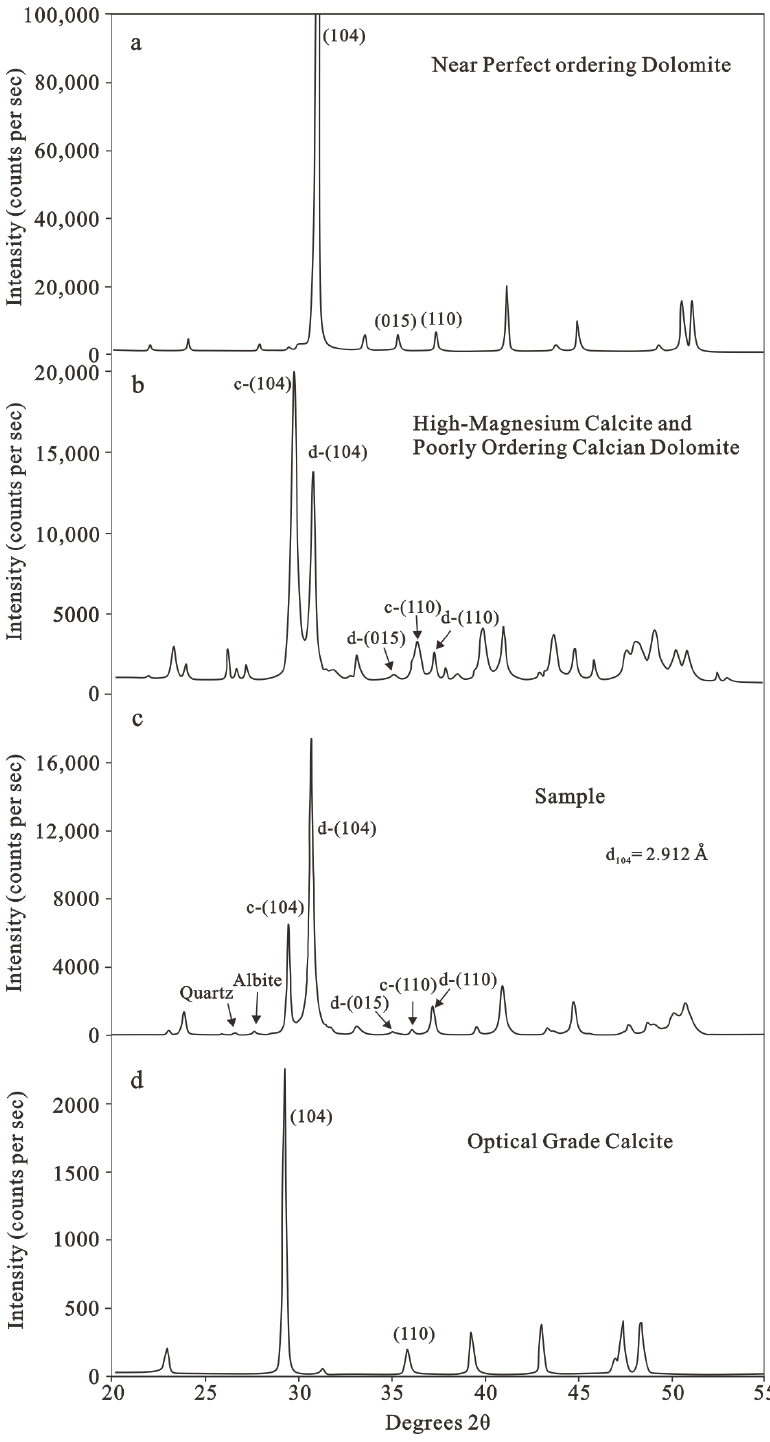
Figure 3. X-ray diffraction patterns of dolomite and calcite. Diffraction patterns of ( a ), ( b ) and ( d ) are from Gregg et al. [36]; ( c ) diffraction pattern of the sample Z1-15.